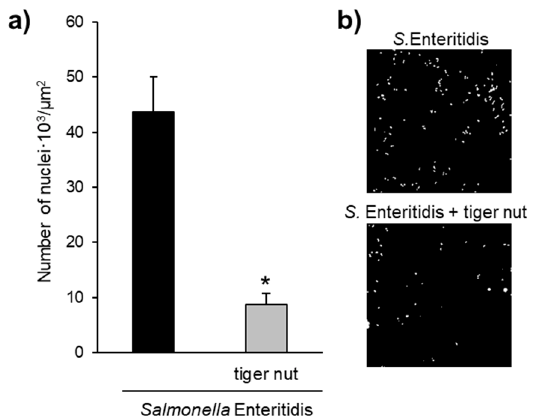
Figure 3. Bacterial agglutination capacity of tiger nut. SEM images of cultures incubated for 3 h ( a ) and ( b ) in the presence of S . enteritidis (MOI 10), and ( c ) in the presence S . enteritidis (MOI 10) in addition to tiger nut (2.5 mg/mL). Representative results were reproduced in three separate exper ‐ iments. The white bar represents 1 μ m.